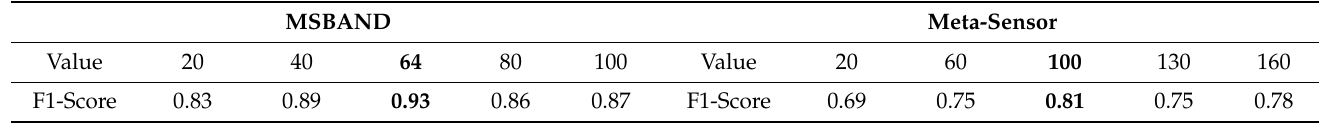
Table 3. Smooth_Window tuning for MSBAND and meta-sensor datasets,